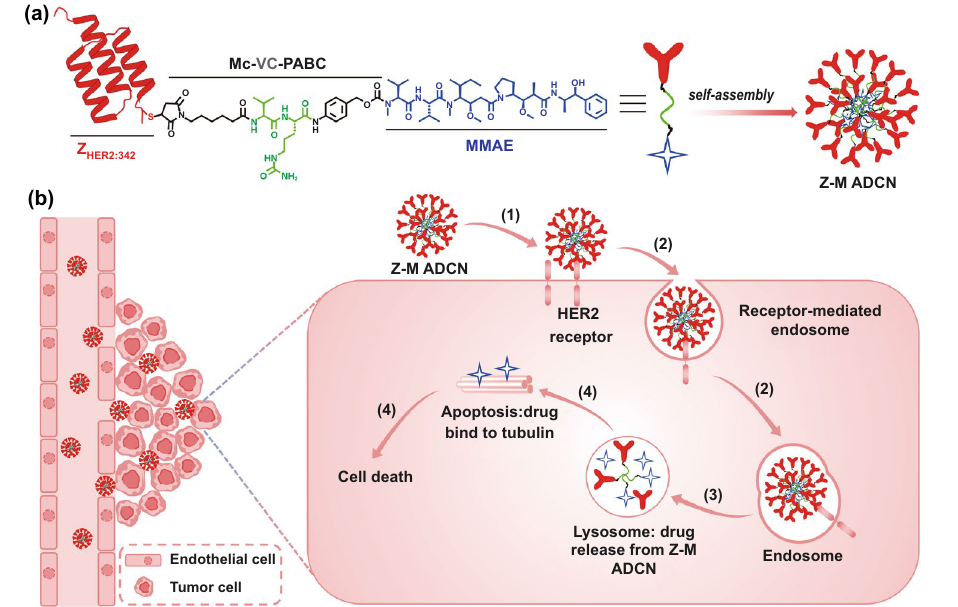
Fig. 1 Schematic representation of Z-M ADCN for targeted cancer therapy. a The structure of Z HER2:342 -MMAE conjugate. It consists of a Z HER2:342 -Cys peptide (red), a maleimide attachment group (black), a Val-Cit dipeptide (green), a PABC spacer group (black), and a cytotoxic MMAE (blue) in sequence. The amphiphilic conjugate molecules self-assemble into nanomicelles in water, and each of the nanomicelles have a MMAE core and a Z HER2:342 shell. b Illustration of the tumor targeting delivery of Z-M ADCN. ( 1 ) The Z HER2:342 affibody of Z-M ADCN binds to the HER2 receptors on the tumor cell surface. ( 2 ) The Z-M ADCN is internalized by HER2 receptor-mediated endocytosis. ( 3 ) MMAE is released from Z-M ADCN through the cleavage of the Val-Cit dipeptide by cathepsin B enzyme in lysosome. ( 4 ) MMAE inhibits the tubulin polymerization and subsequently induce the cell apoptosis to